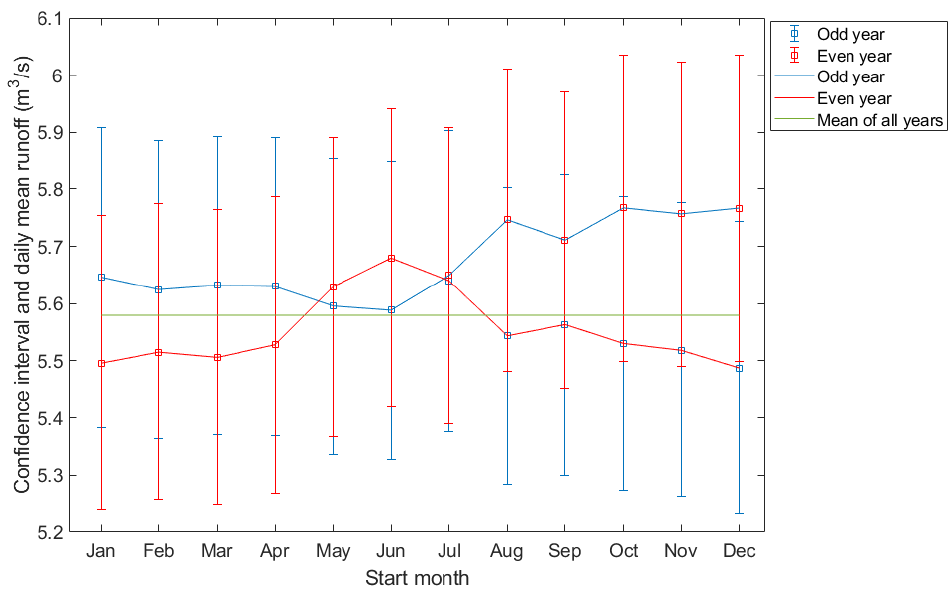
Figure 6. Averaged daily runoff (m 3 /s) over 1961–2011 for the 64 subcatchments of the Dalälven River basin in units of m 3 /s using different start months. Each start month provides up to 25 yearly samples in odd or even years, and the bars indicate the 95% confidence interval of the mean value estimate (using a t-distribution).